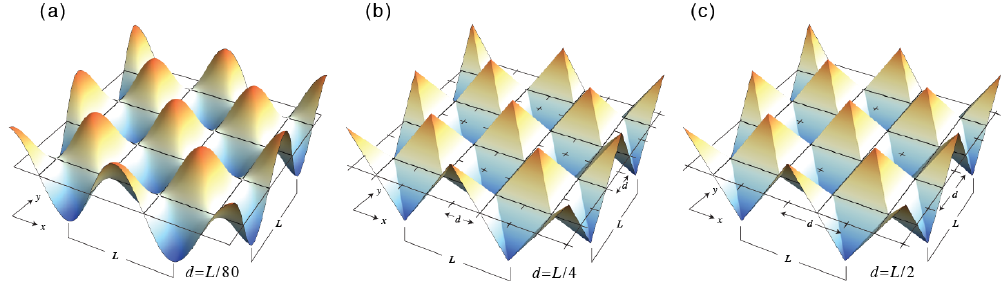
Figure 12. Initial perturbations used in the simulations with the Z-, C-, CD- and D-grid models for the grid spacings of (a) d = L/ 80, (b) d = L/ 4 and (c) d = L/ 2